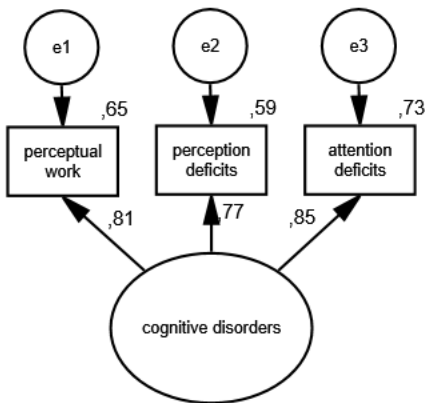
Figure 5. Standardized effects of the measurement model of cognitive disorders in the group of women .